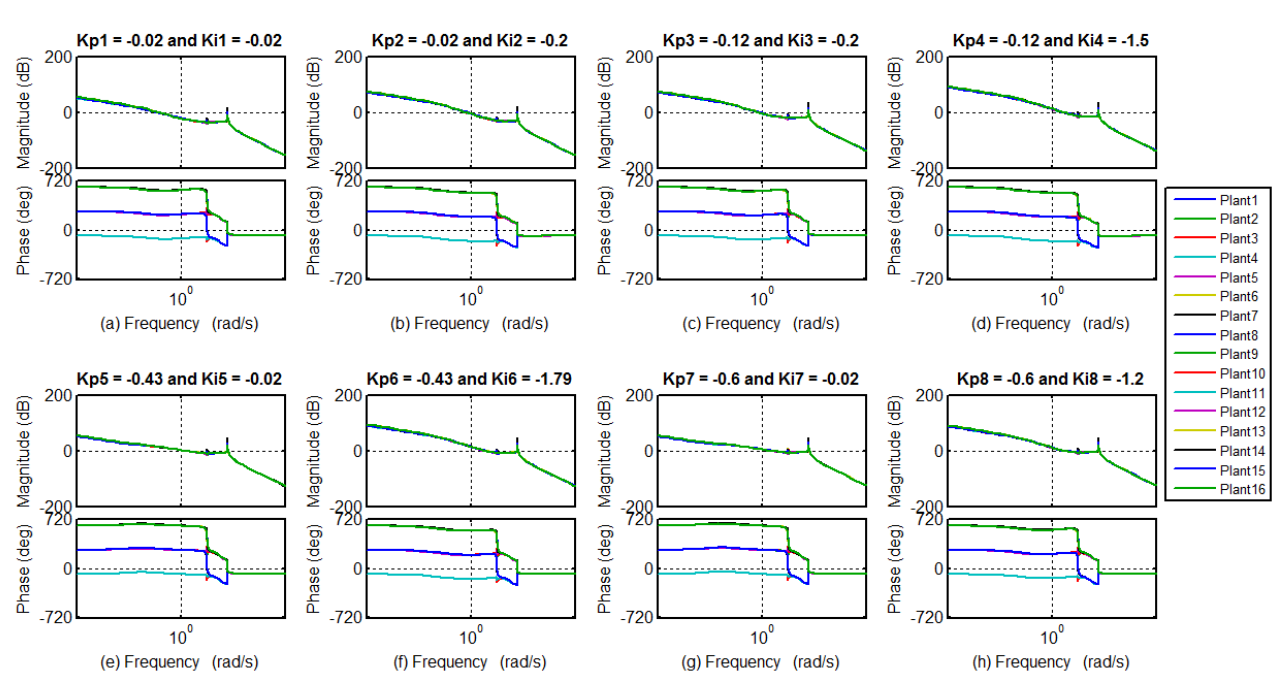
Figure 10. The frequency responses of 16-Kharitonov plants for selected points considered for illustration. The points are taken from the Kp and Ki stabilizing region of Figure 5.